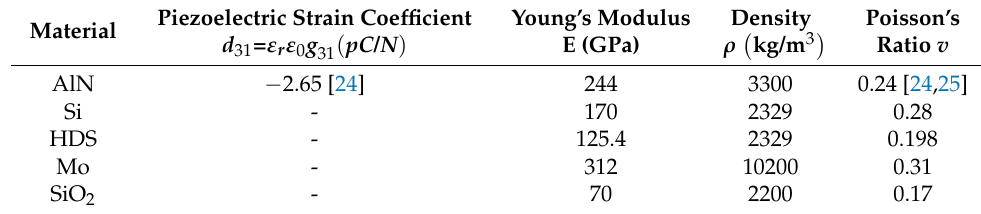
Table 2. Material parameter values in this work.